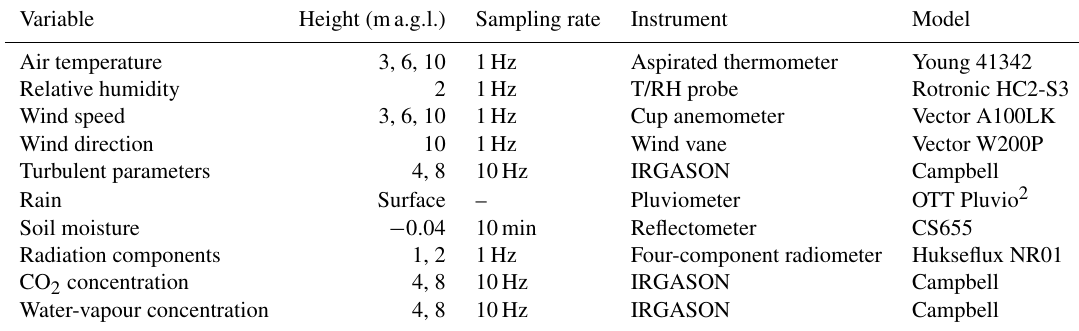
Table 1. Specifications about the variables measured and the devices employed in this study over the intensive summer 2017 campaign (22 June–26 September). Variable Height (ma.g.l.) Sampling rate Instrument Model Air temperature 3, 6, 10 1Hz Aspirated thermometer Young 41342 Relative humidity 2 1Hz T/RH probe Rotronic HC2-S3 Wind speed 3, 6, 10 1Hz Cup anemometer Vector A100LK Wind direction 10 1Hz Wind vane Vector W200P Turbulent parameters 4, 8 10Hz IRGASON Campbell Rain Surface – Pluviometer OTT Pluvio 2 Soil moisture − 0 . 04 10min Reflectometer CS655 Radiation components 1, 2 1Hz Four-component radiometer Hukseflux NR01 CO 2 concentration 4, 8 10Hz IRGASON Campbell Water-vapour concentration 4, 8 10Hz IRGASON